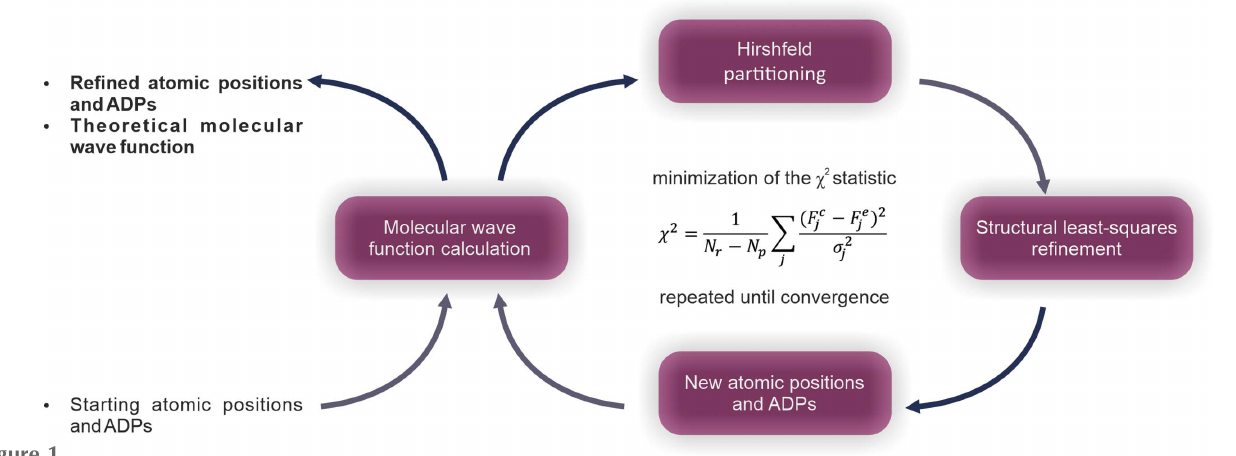
Figure 1 Scheme of Hirshfeld atom